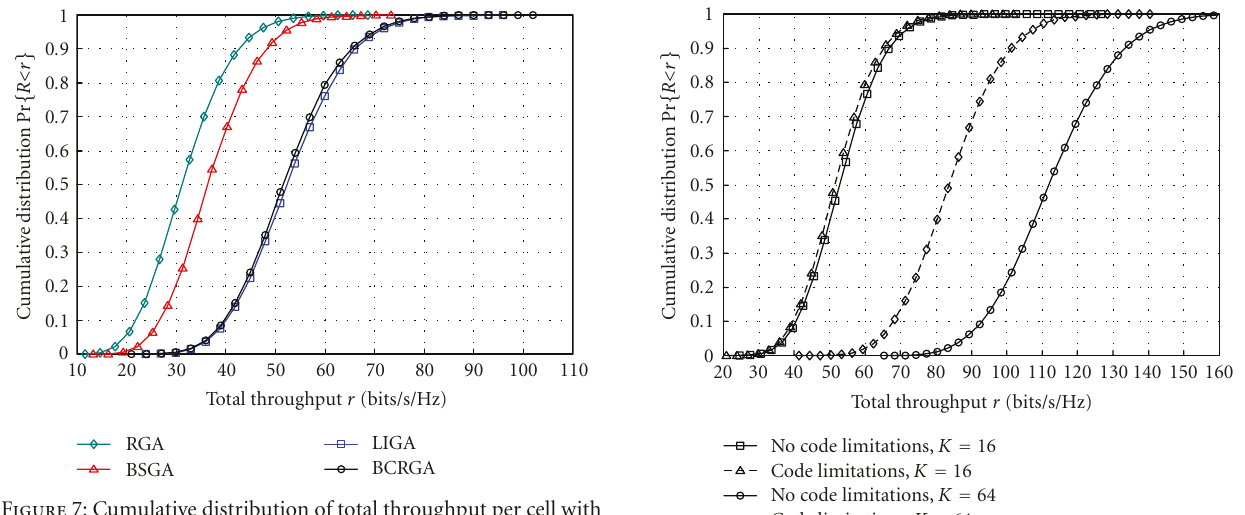
Figure 7: Cumulative distribution of total throughput per cell with code constraints on the number of users per assignment group ( K = 16 users/cell and WFPA in use).